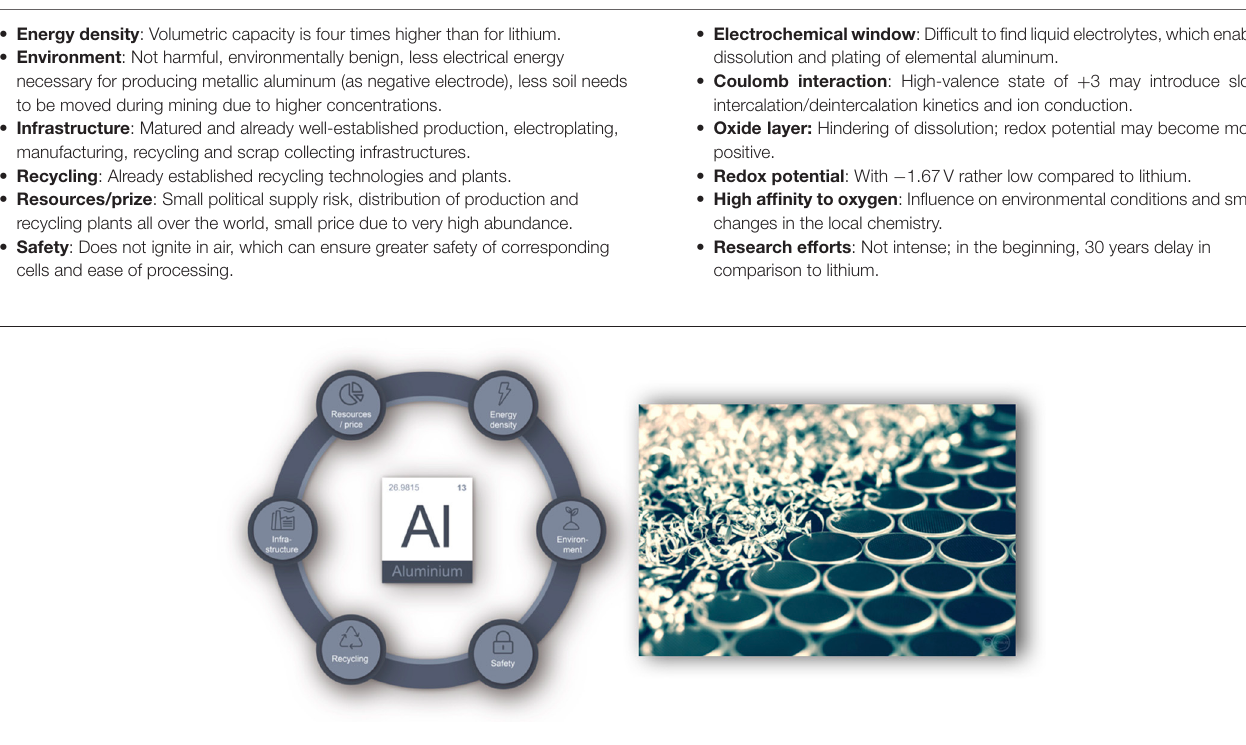
TABLE 2 | Strengths and challenges of aluminum as negative electrode in a battery (in comparison to lithium). Strengths